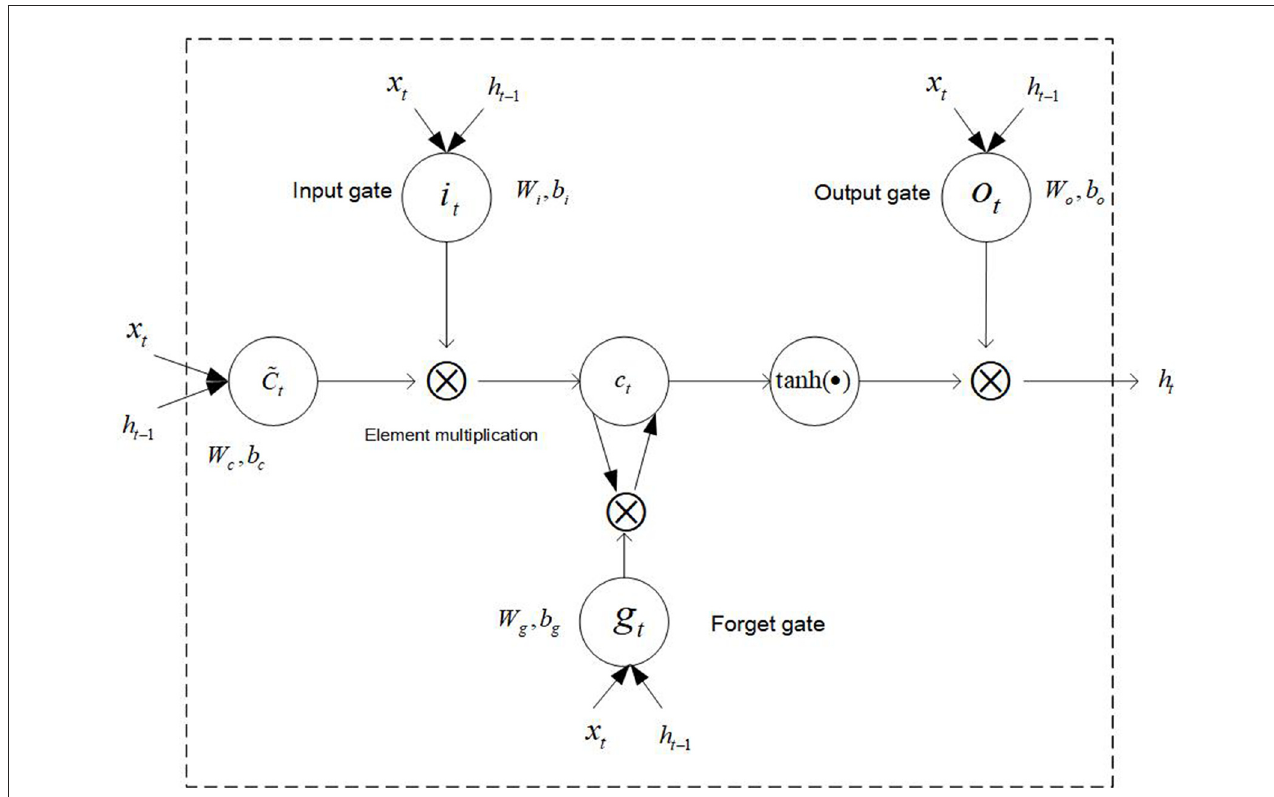
FIGURE5 The schematic diagram of the LSTM model.